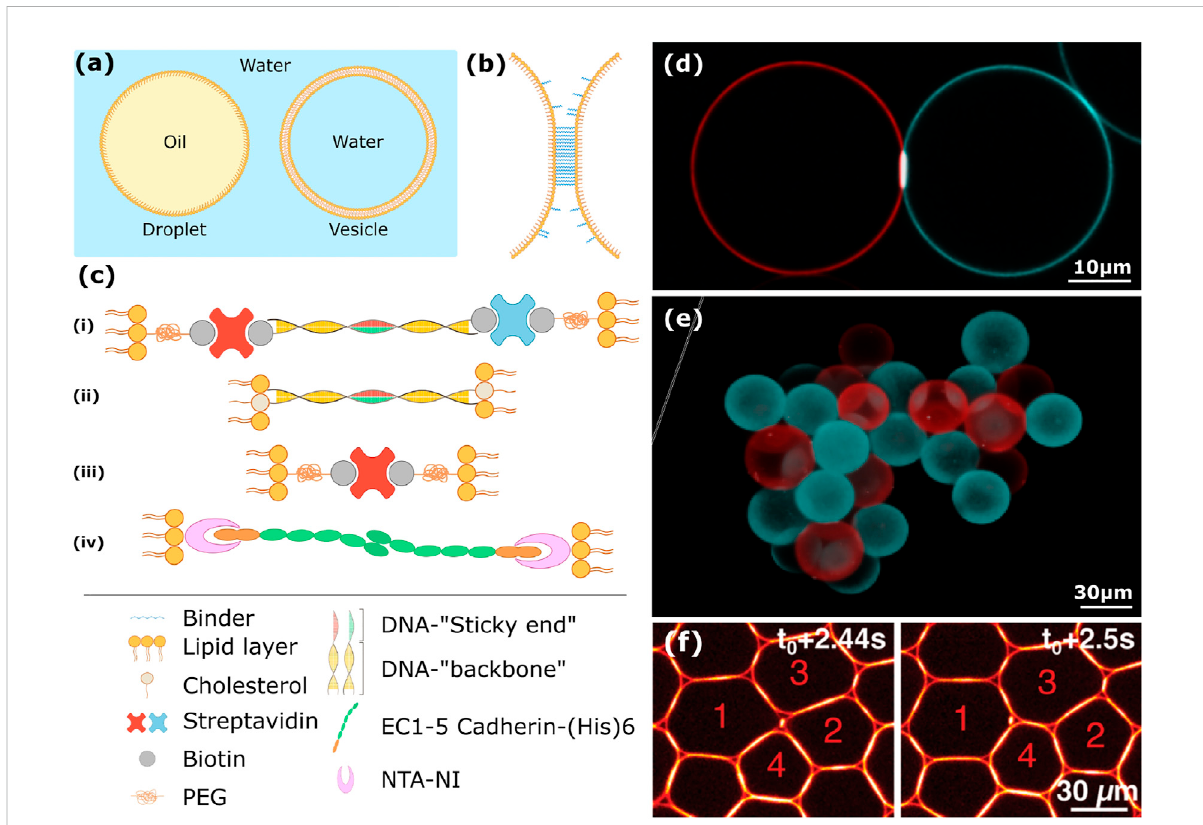
FIGURE 3 Softmattersystemstomimiccell-celladhesion. (A) Schematicrepresentationofbiomimeticdropletsstabilizedbyamonolayeroflipids(left)or biomimeticvesicles(right). (B) Generalrepresentationofadhesionbetweenthesurfacesofdropletsorvesicles:bindersareattached(oranchored)to the hydrophilic heads of the outer lipid layer and bind to each other upon surface contact. (C) Various type of binders that can ensure speci fi c adhesion, from top to bottom: (i) DNAstrands carrying abiotin tag are grafted to a streptavidinwhichis itself attached biotinylated-PEG groups on the hydrophilic heads of the lipids, or (ii) the DNA strands are directly anchored in the lipid layer through a cholesterol tag. In both cases the DNA sequence usually contains a spacer sequence, made out of a stiff double stranded DNA (represented here in yellow) or a fl oppy single stranded, followed by a sticky end. The complementary sticky ends of neighboring surfaces interact together to form a complementary double helix upon contact (red/green sequence); (iii) binding through biotin-streptavidin-biotin interactions. The biotinylated lipids on one surface adhere to biotinylated lipids decorated with a streptavidin on a contacting droplet; (iv) adhesion through the extracellular domains of E-cadherin attached to NTA-Ni lipids through a poly-histidin tag. (D) Confocal microscopy of two silicon oil droplets adhering to each other through complementary DNA sticky ends. The color of the droplet codes for the sequence, leading to adhesion patches only at the red/green contacts. (E) Reconstitution of a 3D packing of oil droplets adhering through complementary strands of DNA. (F) Confocal image of silicon oil droplets functionalized with fl